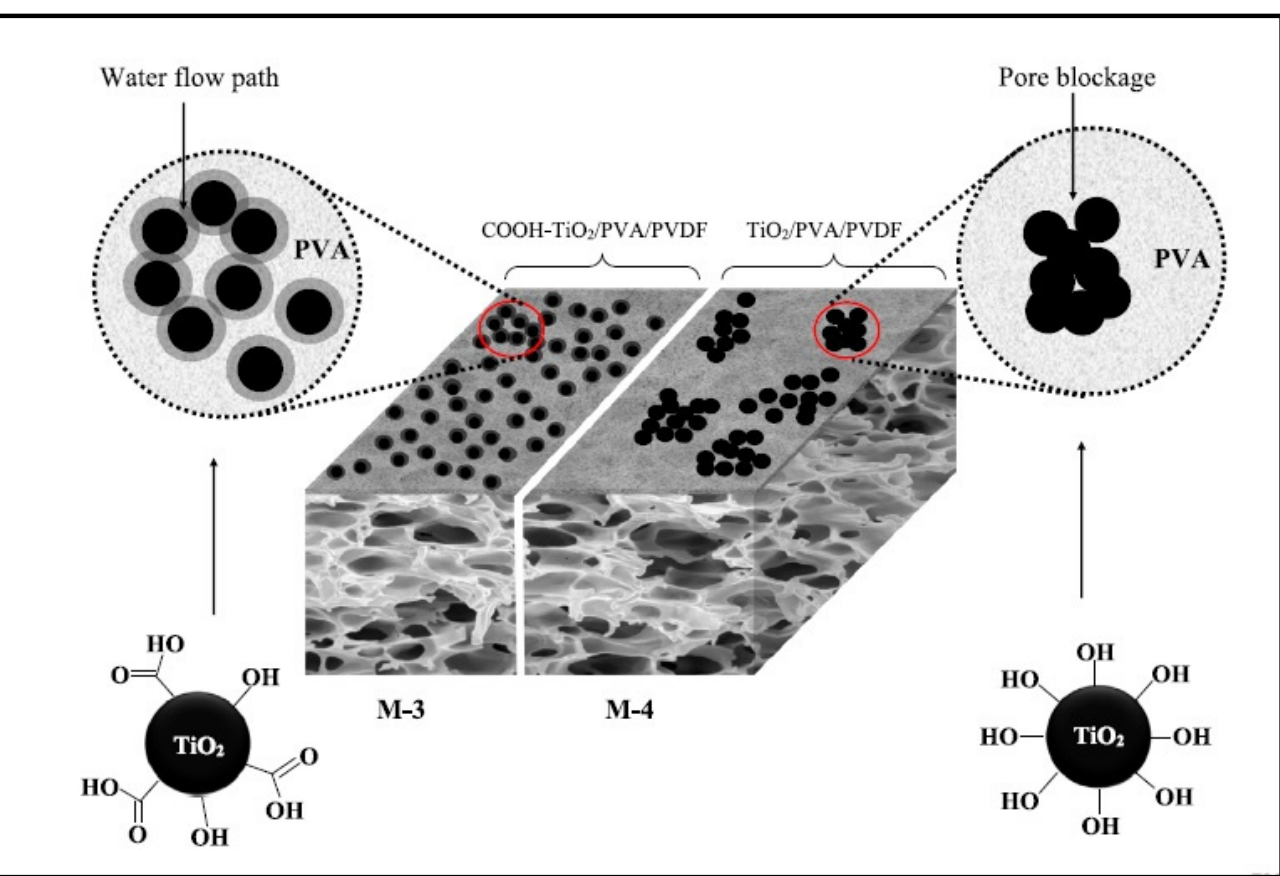
Figure 4. The dispersion of Titanium dioxide (TiO 2 ) nanoparticles in membrane (M-3) vs. agglomeration of TiO 2 in membrane (M-4). Reprinted with permission from ref. [35]. © 2015 Elsevier B.V.